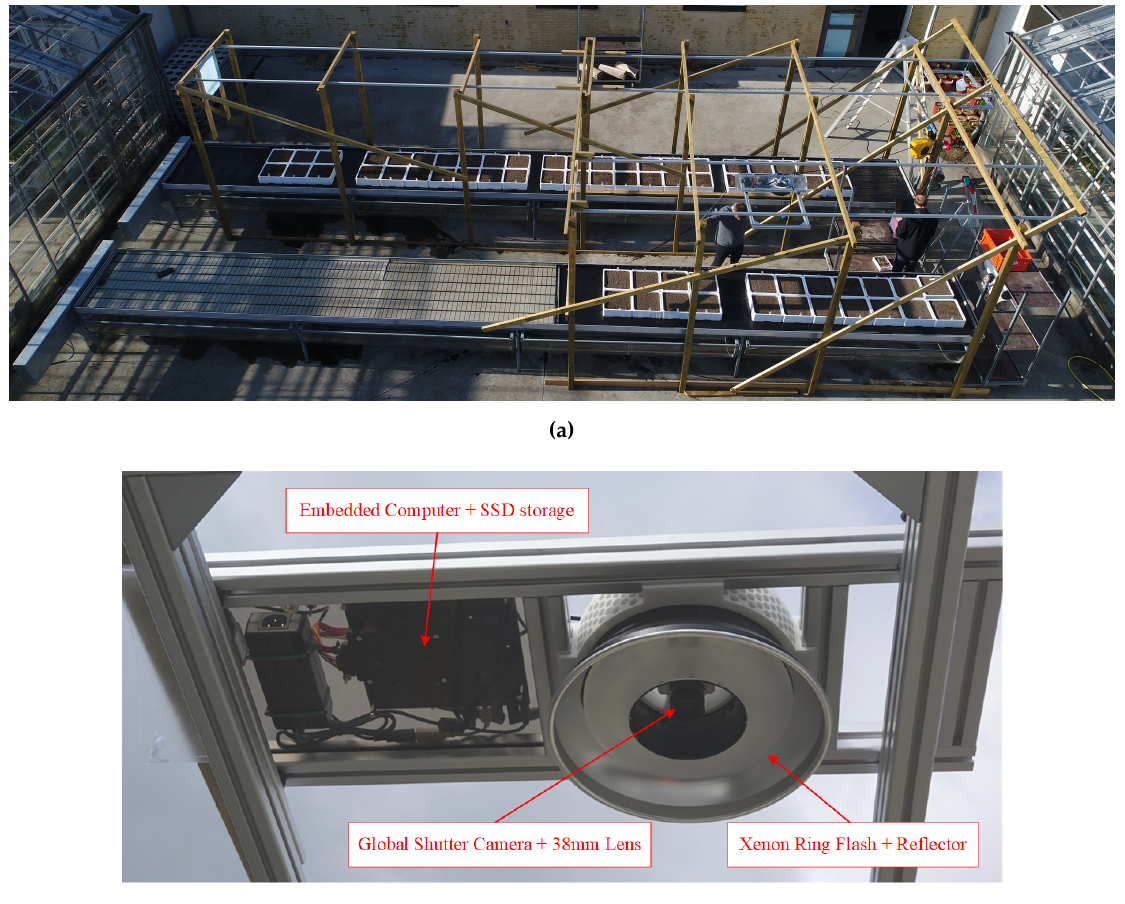
Figure 1. Data acquisition setup. ( a ) Bird’s-eye view of the data acquisition setup. The image shows the polystyrene boxes placed on the outdoor test tables, while the imaging system mounted on the railing system during a test of the system. The test tables rain covers are stored away under the tables when rain is absent. ( b ) Frog’s-eye view of the imaging